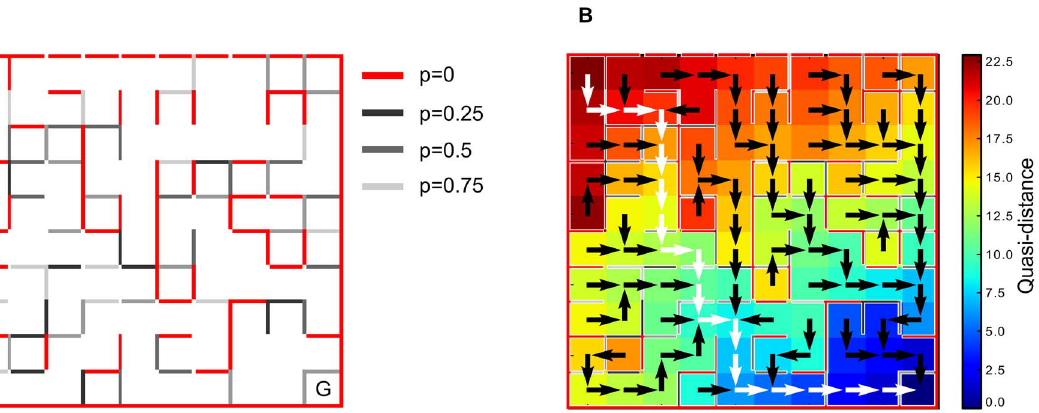
Figure 1. Example of a simple probabilistic maze of size 10 | 10 where dynamic programming and quasimetric methods are equivalent. (A) S is the starting state and G the goal. The red wall cannot be traversed (transition probability p ~ 0 ) while gray ones can be considered as probabilistic doors with transition probability 0 v p v 1 . 5 actions are considered: not moving, going east, west, south and north. (B) Quasi-distance obtained for the probabilistic maze example with a constant cost function ( V x , u : g ( x , u ) ~ 1 ) and corresponding policy. White arrows represent the optimal policy from position S to G. Black arrows represent the optimal policy to reach G from other positions.